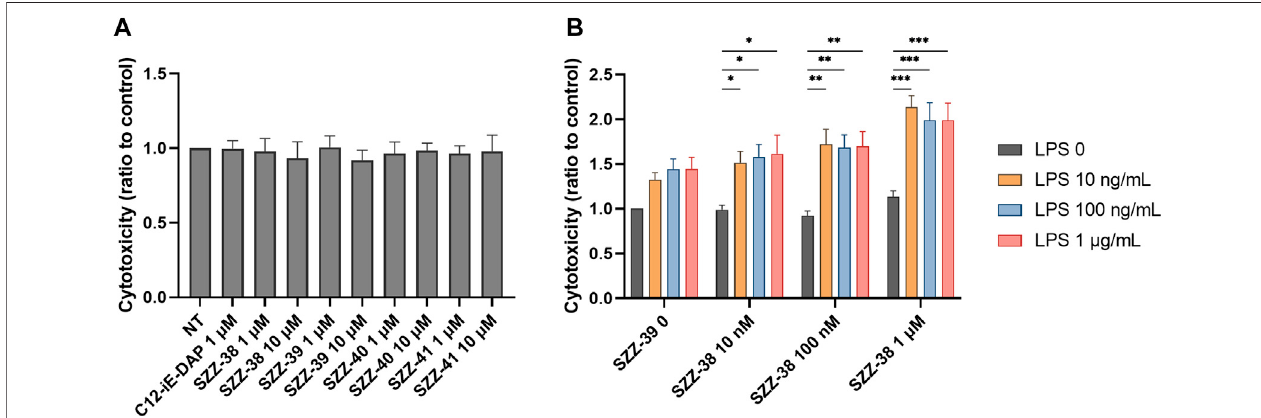
FIGURE 4 | Effect of NOD1 agonists and LPS on the cytolytic activity of PBMCs against K562 cells. (A) PBMCs were treated for 18 h with C12-iE-DAP (1 µM) or NOD1 agonists (1 and 10 µM), before the addition of K562 cells. Cytotoxicity was determined after 4 h of co-incubation. (B) The concentration-dependent effect of NOD1/TLR4agonistcombinationsontheinductionofPBMCcytotoxicity.Dataareshownrelativetothenegativecontrol(0.1%DMSO)andexpressedasmeans±SEM of three independent experiments. Statistical signi fi cance was determined by two-way ANOVA followed by Dunnets multiple comparisons test; *, p < 0.05, **, p < 0.01, ***, p <